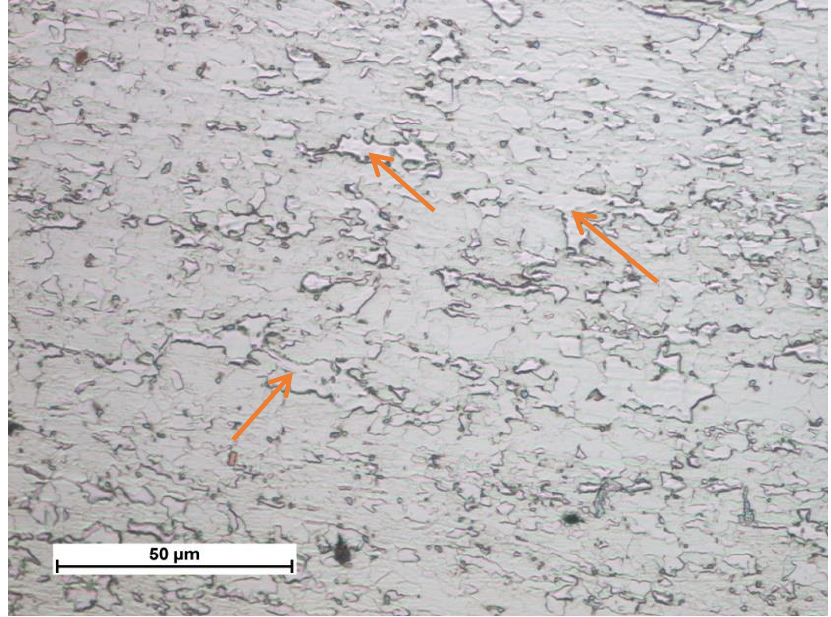
Figure 2. Structure of bainitic-ferritic steel S700MC (plastic deformed areas are marked with an arrow).